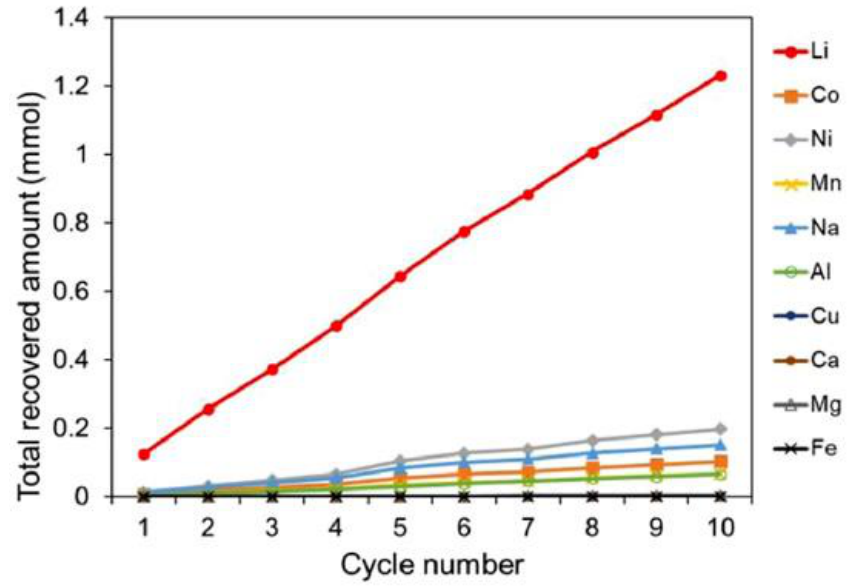
Figure 13. Total recovered amount of the ions from the LIB leachate for 10 cycles of lithium recovery. Reprinted with permission from Ref. [78]. Copyright 2021 Elsevier.